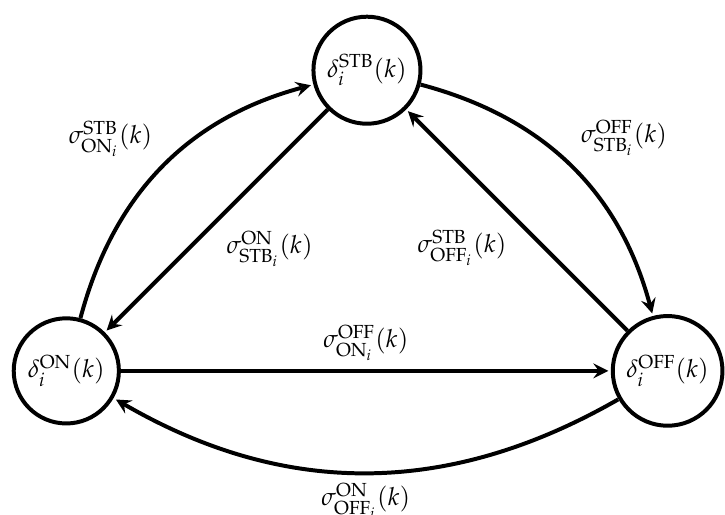
Figure 2. Automata of the electrolyzer ( i = e ) and of the fuel cell ( i = f ). Each node represents a particular state (i.e., operational mode), while the edges represent the state transition, for each i ∈ { e , f }